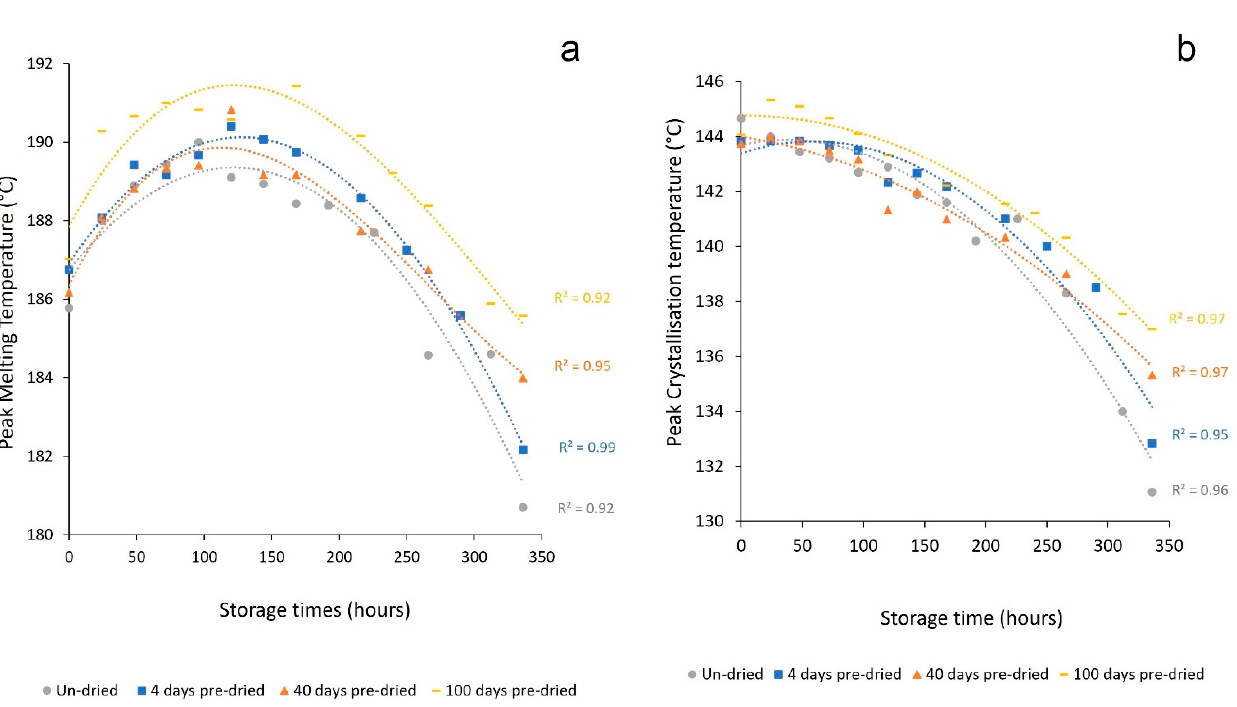
Figure 14. The effect of drying PA − 12 powders before oven conditioning on the growth of the imide peak and sample discolouration. 4. Conclusions This investigation included a unique analysis of conditioned PA − 12 samples using FTIR, a technique rarely utilized in PBF literature, in addition to DSC. Characterisation indicated that across 336 h of oven conditioning, there were two separate, time-dependant